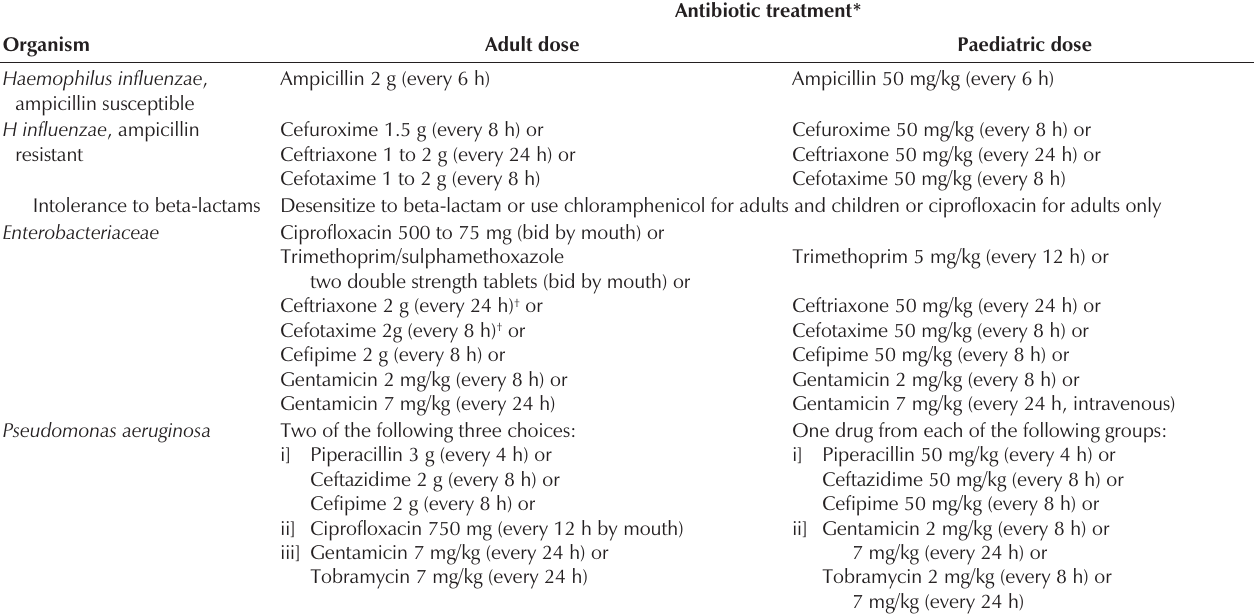
Pathogen-specific therapy: Antibiotics of choice for common Gram-negative cocci